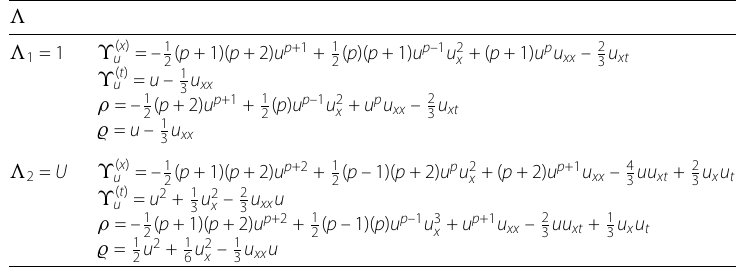
Table 5 Conservation laws for Eq.